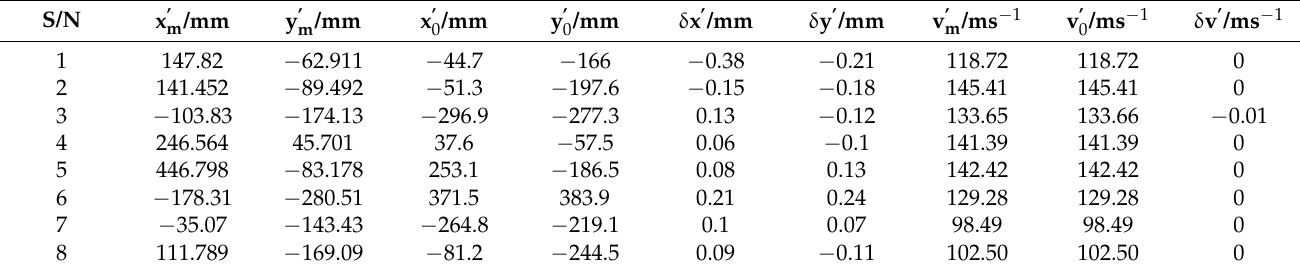
Table 4. Statistics of test data corresponding to Table 3.